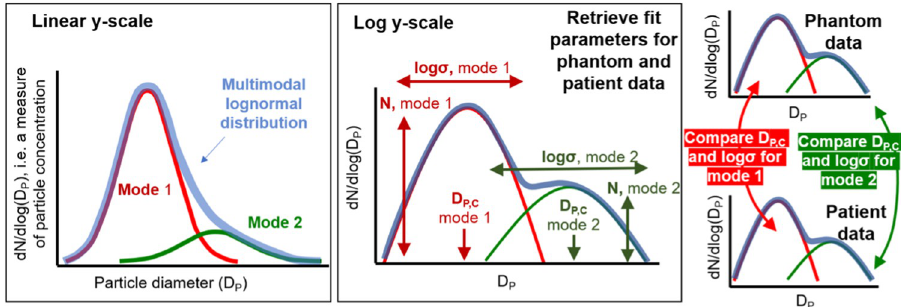
Fig 1. Description of the parameters used to describe the average size distribution detected above background. The mode width is described by log sigma ( σ ) and the peak of the mode by D P,C . Mode amplitude parameter (N) was not compared, as it is highly dependent on sampling